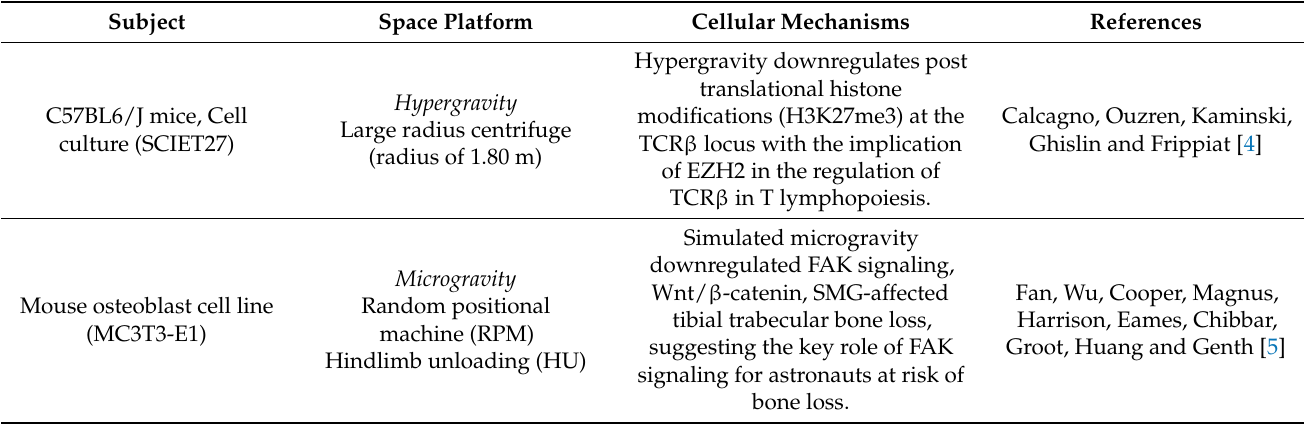
Table 1. Summary of the IJMS Special